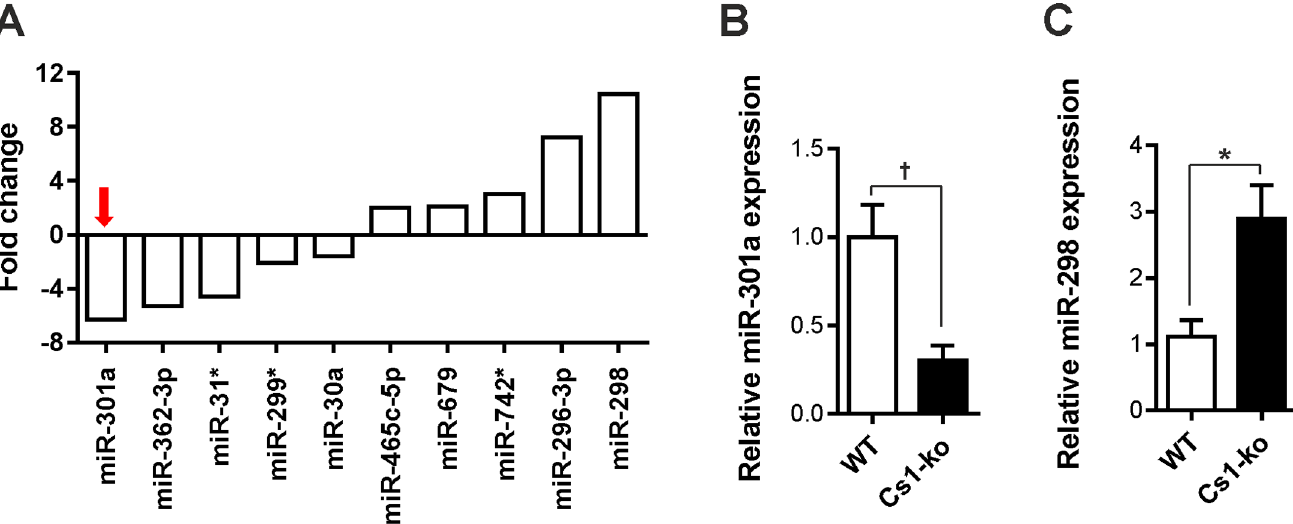
Fig 2. MicroRNA miR-301a is downregulated in Cs1-ko mice. Microarrayanalyseswere performed on Illumina Mouse Sentrix-6 BeadChiparrays (Illumina, Inc.) using total RNA isolatedfrom Calsarcinknockout (Cs1-ko) and wild-type(WT) mice. Microarray scanningwas done using a Beadstation array scanner and analyzedby normalizationof the signals using the quantilenormalization algorithmwithout background subtraction. Differentially regulated microRNAswere definedby calculatingthe standard deviationdifferences of a given probe in Cs1-ko and WT genotypes. ( A ) Bar graph presenting few selecteddysregulated microRNAsin Cs1-ko mice comparedto WT mice. MiR-301awas identifiedthe most downregulatedmicroRNA, whereas,miR-298 was highlyupregulated(N = 4 each), which was confirmedin independent cohort by quantitative real-time PCR for miR-301a( B ), and miR-298( C ) (N = 5 (WT), and 6 (Cs1-ko)). Statistical analysiswas carried out using two-tailedstudent’s t-test . * : p < 0.05,†: p < 0.01.